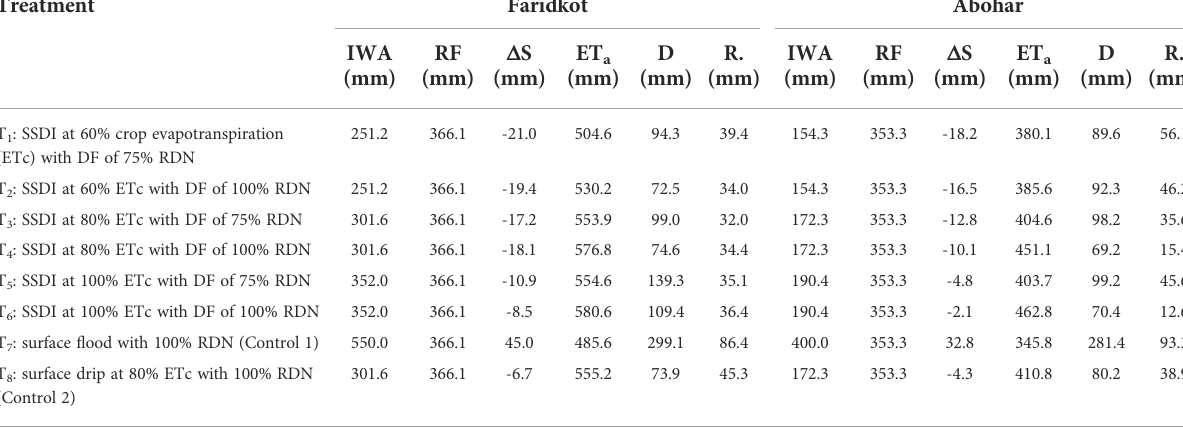
TABLE 7 Irrigation water applied and actual crop evapotranspiration under various treatments (2020). Treatment